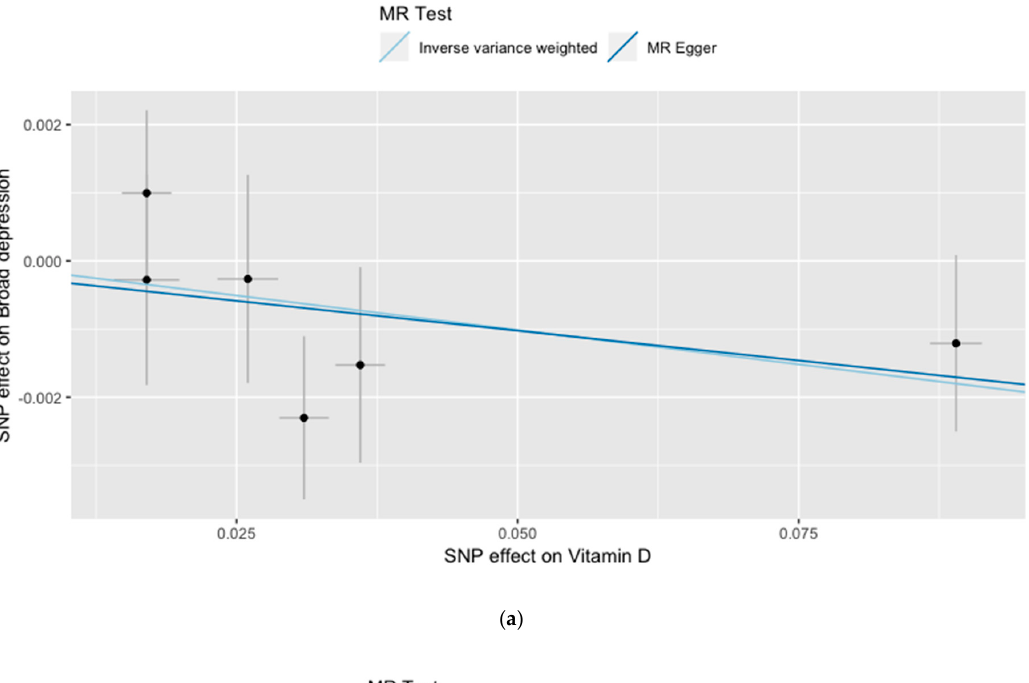
Figure 1. Results of the single and multi SNP analyses for the SNP effect of natural-log transformed 25(OH)vitamin D on ( a ) broad depression, and ( b ) depressive symptoms. The black lines visualize the results of single SNP analyses, the red lines visualize the results of the multi SNP analysis.